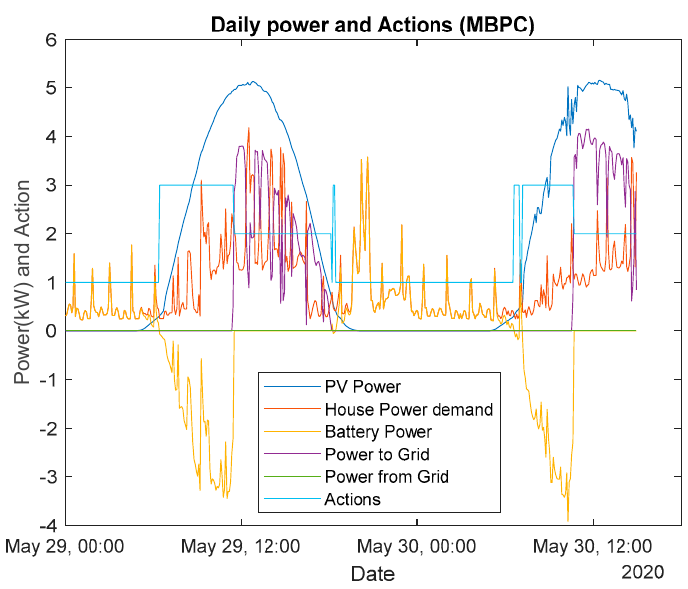
Figure 22. Different power signals, MBPC control (sunny day).